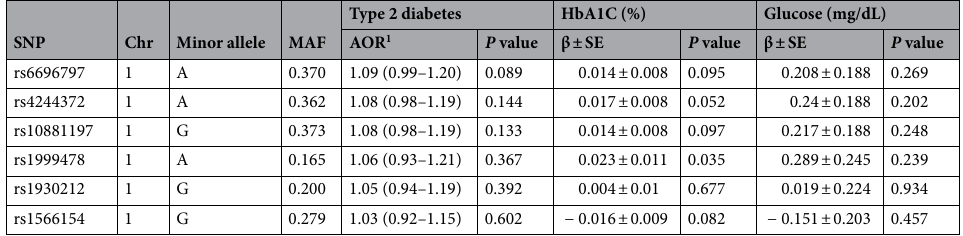
Table 1. SNPs included in the study. Adjusted for age and sex. P value based on the additive genetic model. SNPs single nucleotide polymorphisms, Chr chromosome, MAF minor allele frequency, SE standard error, AOR adjusted odds